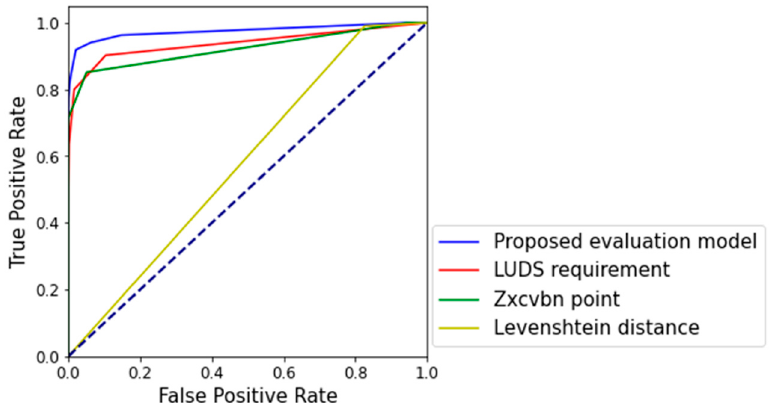
Figure 11. Password security evaluation ROC curve.